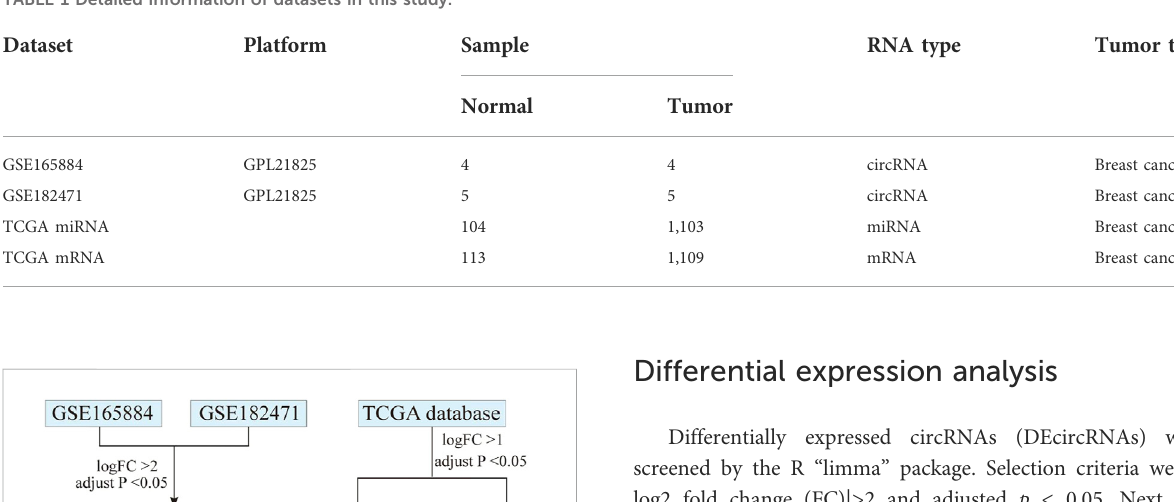
TABLE 1 Detailed information of datasets in this study.